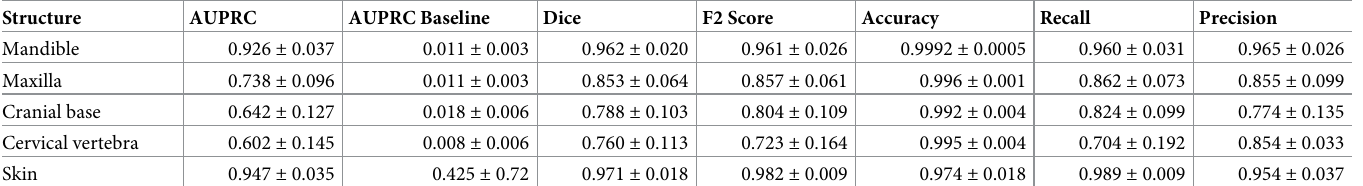
Table 2. Comparison of manual and automatic segmentation using AUPRC, AUPRC-Baseline, Dice, F2 Score, Accuracy, Recall, and Precision of the 5-fold cross- validation for the 5 skull structures